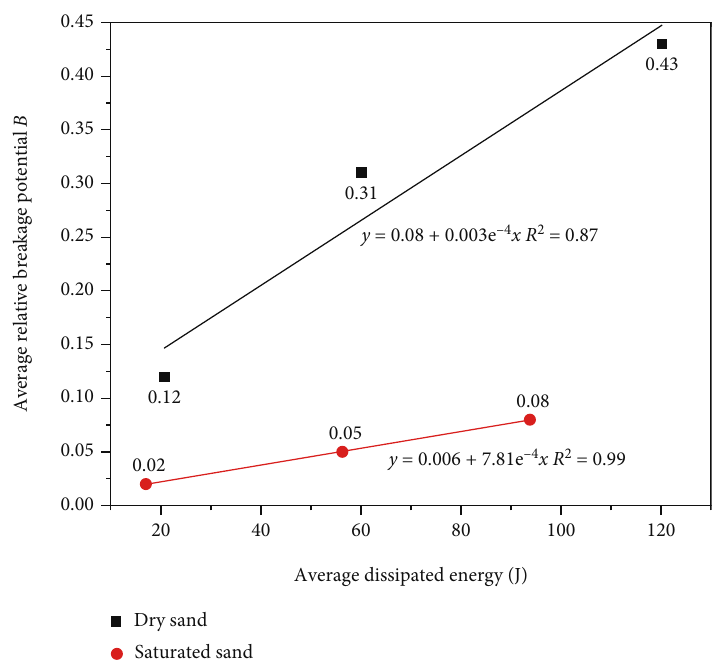
Figure 13: Variation trend of average relative breakage potential B under di ff erent dissipated